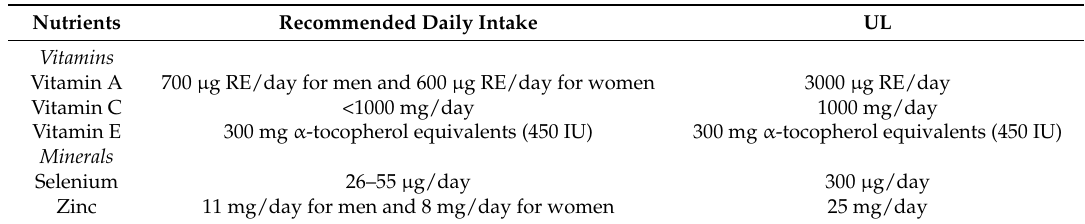
Table 3. Recommended daily intakes and tolerable upper intake level (UL) for vitamins and minerals